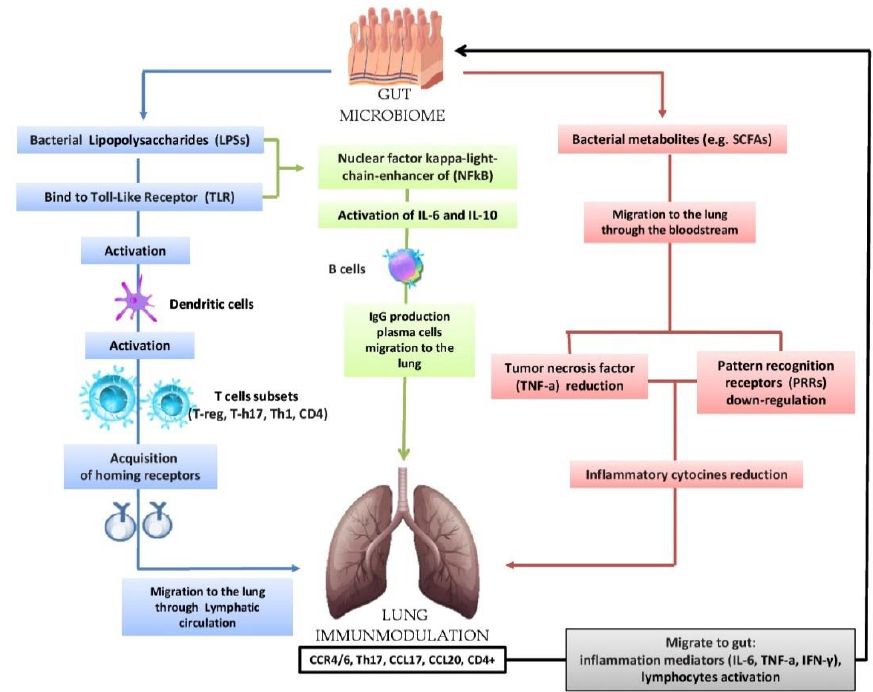
Figure 2. Bidirectional hypothesis that the intestinal microbiota can modulate the immunological activity of the lung: lipopolysaccharides (LPSs) are able to bind to the Toll-Like Receptor (TLR) present on the intestinal mucosa causing the activation of dendritic cells that favor the activation of various T cells (T-reg, T-h17, Th-1, CD4); subsequently, there is the acquisition of horning receptors (CCR6, CCR9, CCR4, a4b7) and migration to the lung through the circulatory lymphatic flow (CCR4 / 6Treg, CCR4 / 6Th17, CCR4 / 6Th1, CCR4 / 6CD4 + ). It also activates (IL-18, INF-y, TNF-a, TGF-b, IL-4, IL-1),